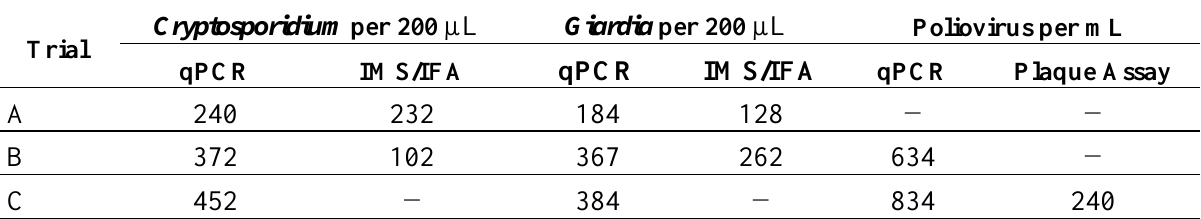
Table 1. Initial Concentration of Spiking Solutions as Measured for each